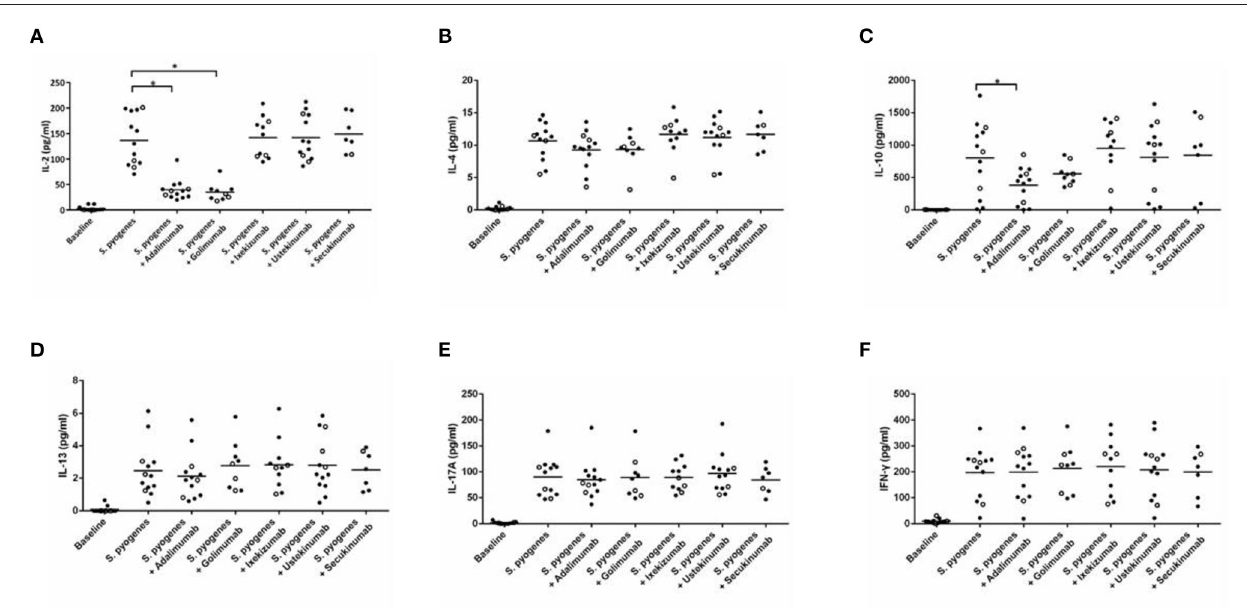
FIGURE 1 | Cytokine expression in peripheral blood mononuclear cells after induction with S. pyogenes and treated with different biologics. (A–F) depict the levels of cytokines (shown on the y-axis) in response to the application of listed biologics (shown on the x-axis) after induction by S. pyogenes . Each circle represents cell cultures from one patient. In all panels, the three TNF- α inhibitor-induced SLE patients are marked with hollow circles. Black bars in each column indicate the mean cytokine concentration. TNF- α inhibitors significantly inhibited S. pyogenes -induced IL-2 (A) ( p < 0.001 in adalimumab, p < 0.001 in golimumab, respectively) and IL-10 (C) expression ( p = 0.039 in adalimumab).